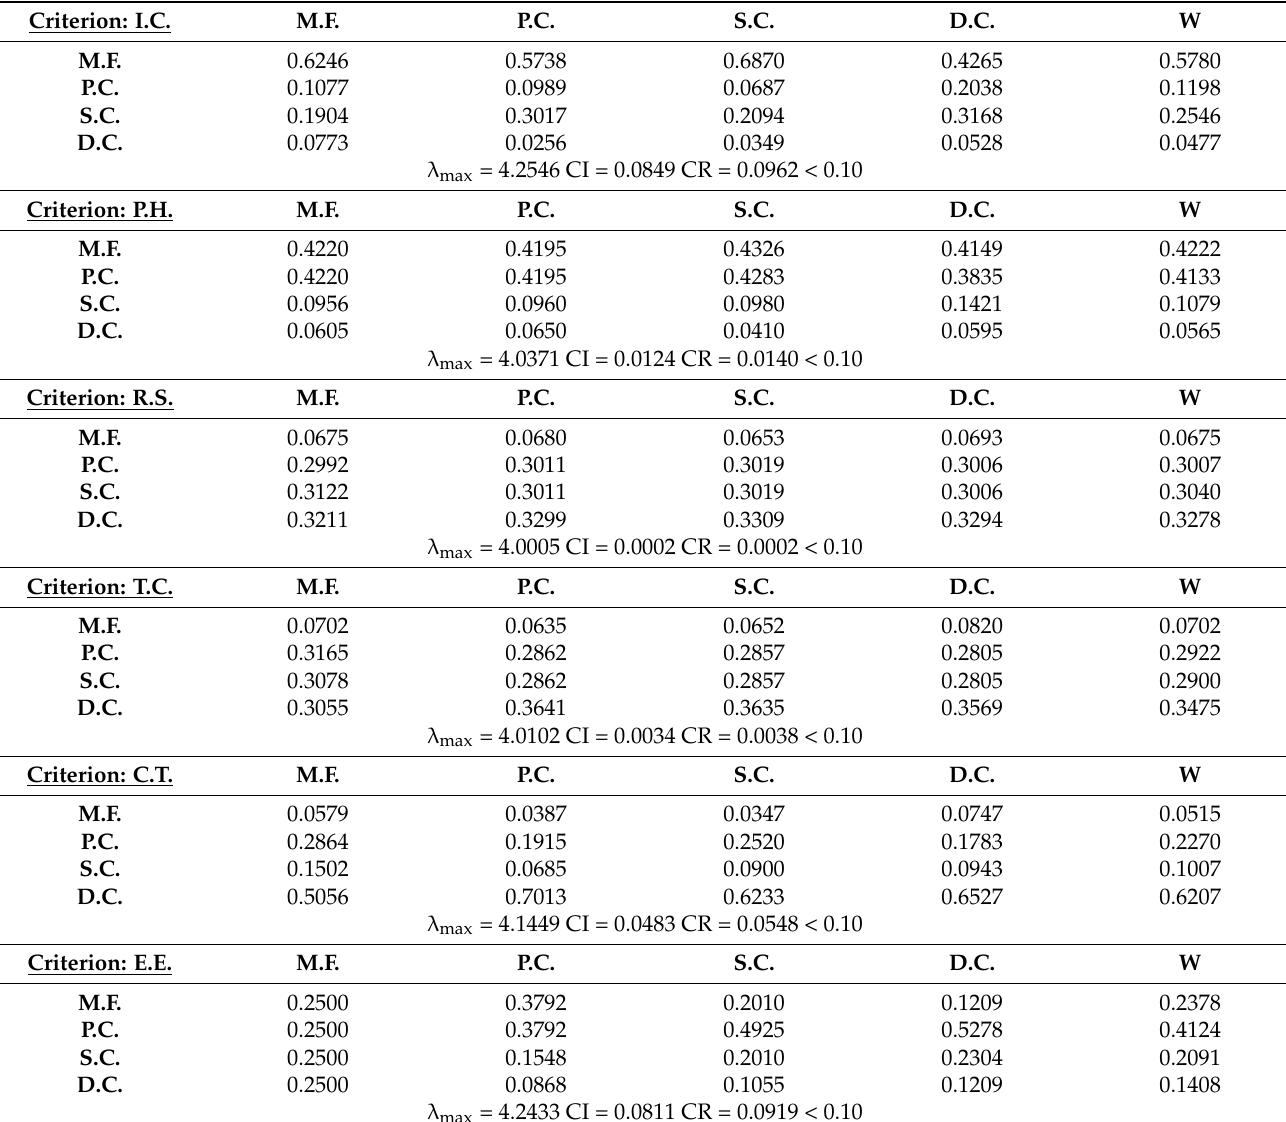
Table 10. Normalized alternatives’ pair-wise comparison matrices, priority vectors (W) and consistency control for each criterion. Criterion: I.C.